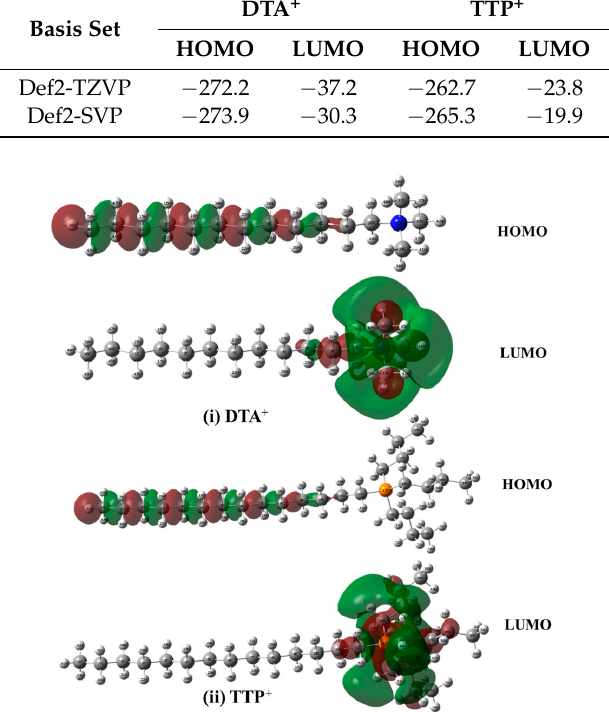
Figure 4. The diagrams of highest occupied molecular orbital (HOMO) and lowest unoccupied molecular orbital (LOMO) of ( i ) DTA + and ( ii ) TTP + at wB97XD/Def2-TZVP level.